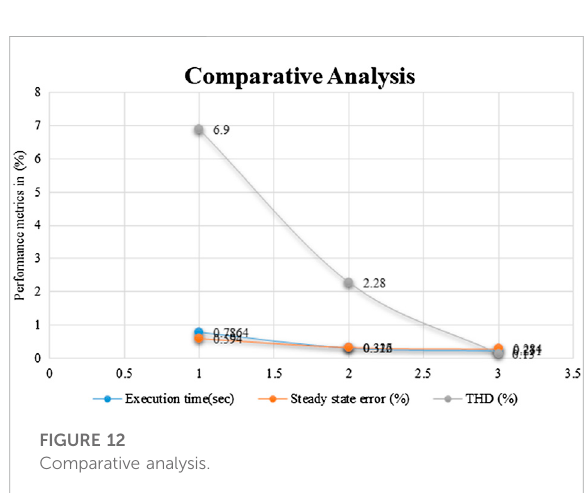
FIGURE 12 Comparative